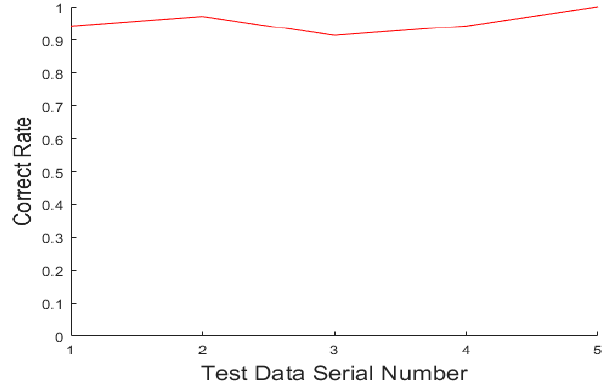
Figure 11. The correct rate of cross-validation.